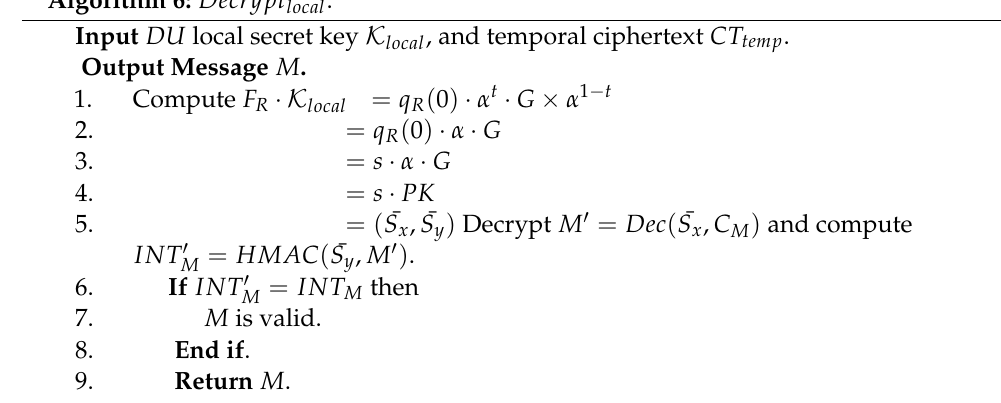
Algorithm 6: Decrypt local